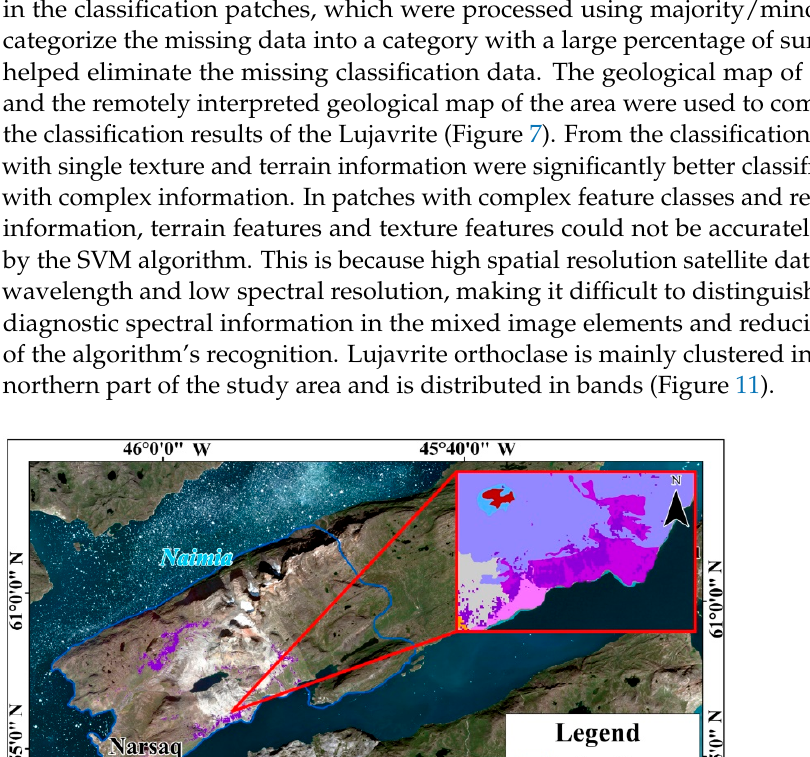
Figure 10. ( A ) Relief feature; ( B ) PCA feature; ( C ) Contrast feature; ( D ) Angular second-order mo- ment feature; ( E ) Homogeneity feature; ( F ) Phase dissimilarity feature.